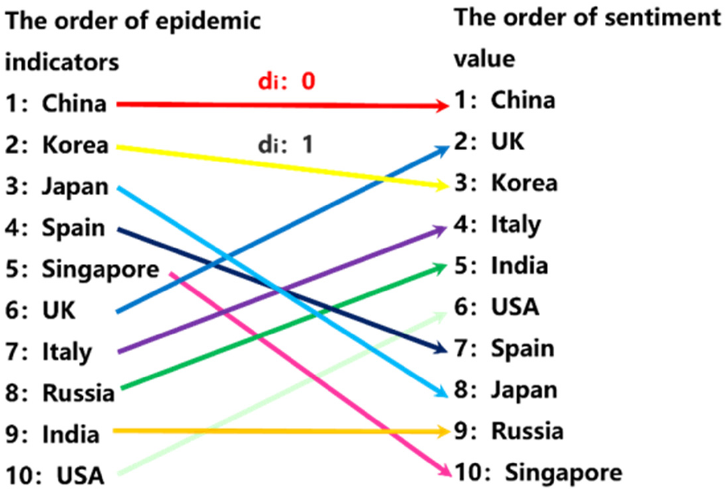
Figure 3. The schematic diagram of ranking difference.